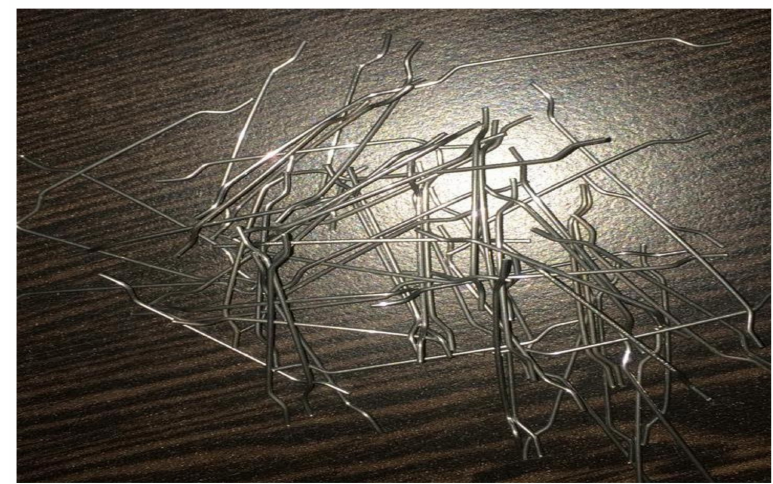
Figure 2. Steel fibers (30 mm length and 0.5 mm diameter).